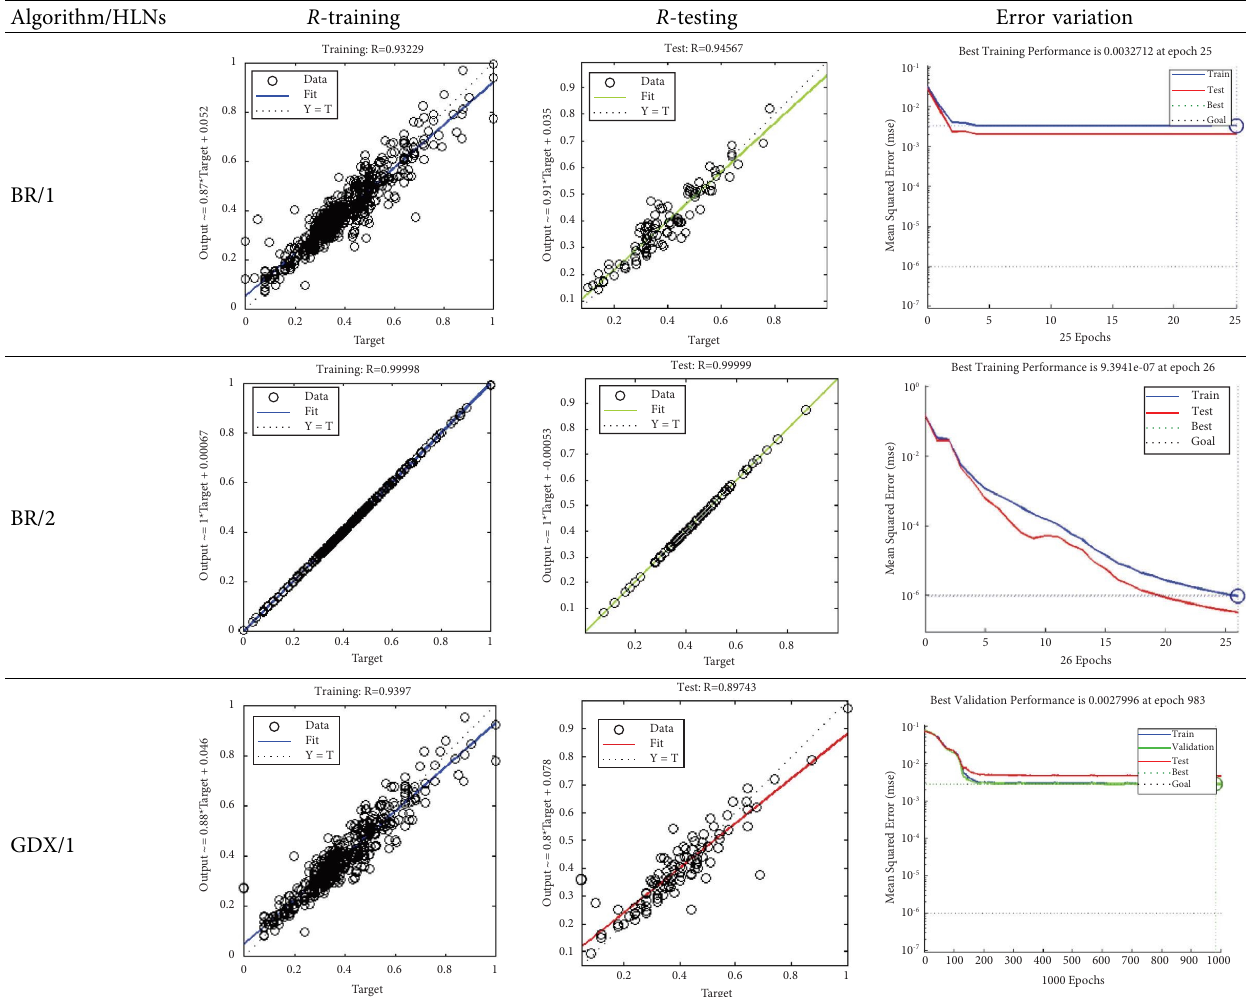
Figure 2: ANN model topology for predicting milk production and investment. Table 2: Performance of ANN models with diferent training algorithms and hidden layer neurons